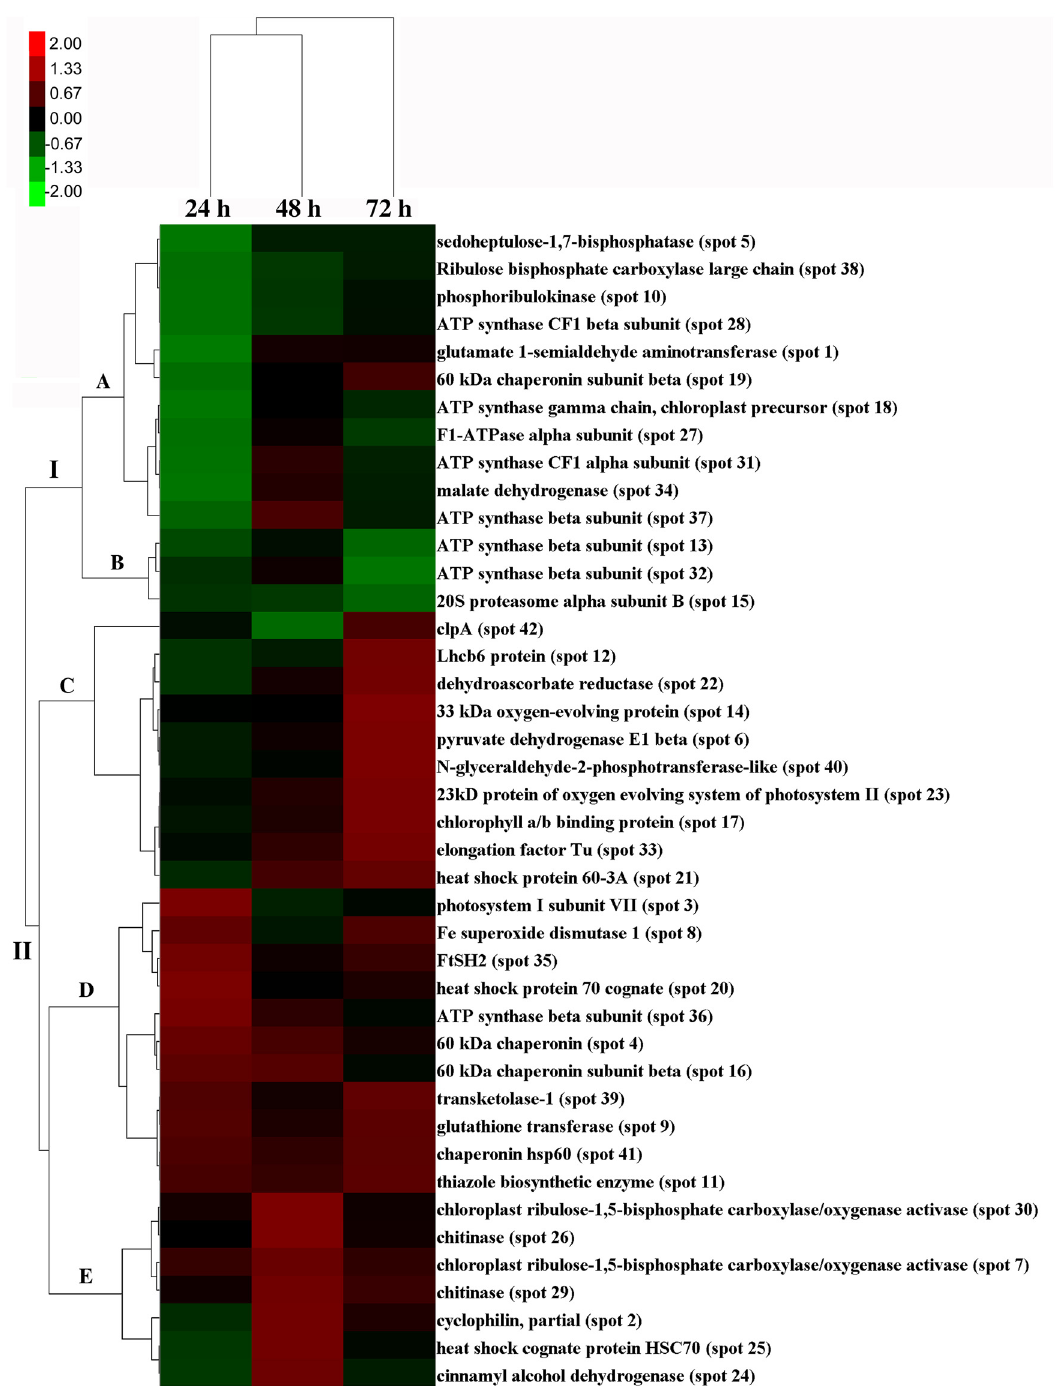
Fig 6. Hierarchical cluster analysis of the dynamic profiles of the 42 identified proteins. Fold changes of protein abundance were log 2 transformed. Columns 1, 2, and 3 represent 200 mM NaCl treatment for 24 h, 48 h, and 72 h, respectively. The rows represent individual proteins. Protein names and spot numbers are labeled to the right of the corresponding heat maps. The proteins that increased and decreased in abundance are indicated in red and green, respectively. Proteins showing no significant changes are indicated in black. The intensity of the colors increases with increasing accumulation differences, as shown to the left of the bar. I and II indicated Cluster I and II, while A-E indicated subgroup